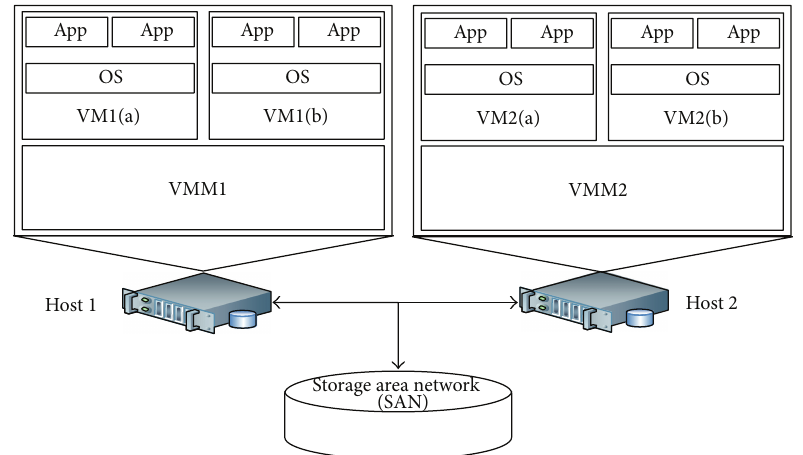
Figure 1: Architecture of a virtualized servers